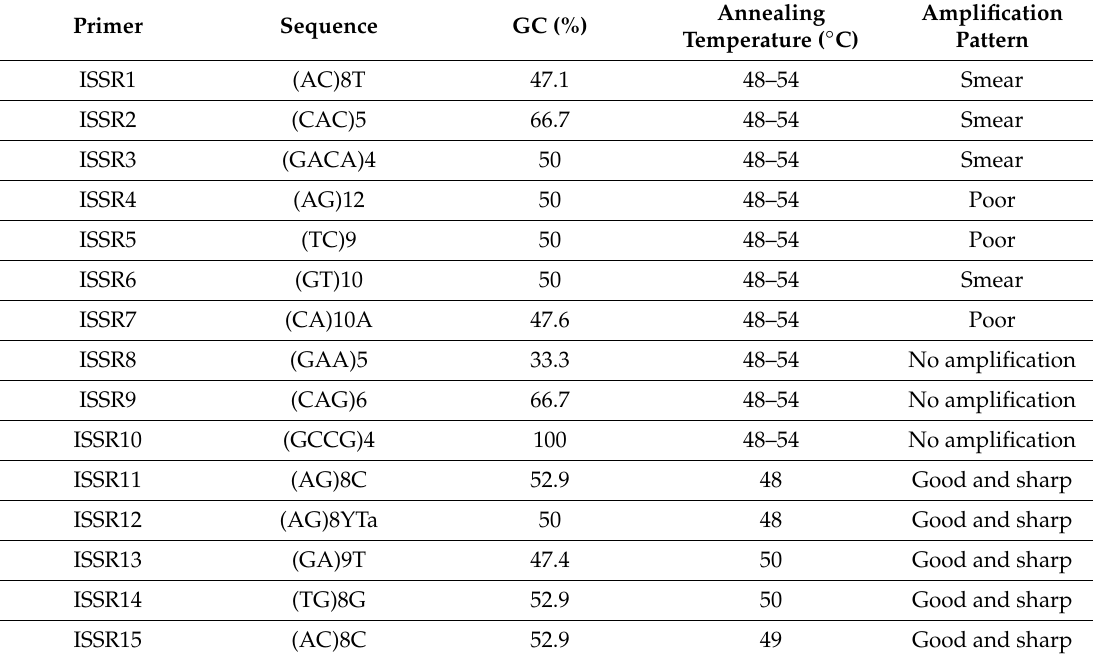
Table 3. List of primers screened for Inter-Simple Sequence Repeats (ISSR)